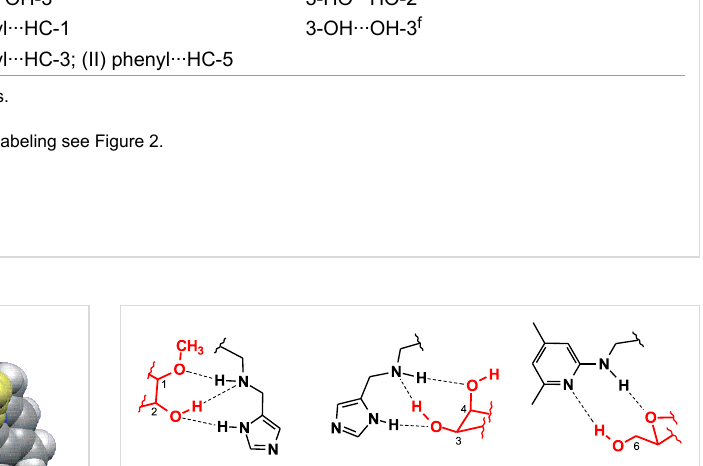
Figure 8: Examples of hydrogen bonding motifs indicated by molecular modeling studies in the 1:1 complex between receptor 4 and β-galactoside 8b (MacroModel V.8.5, OPLS-AA force field, MCMM, 50000